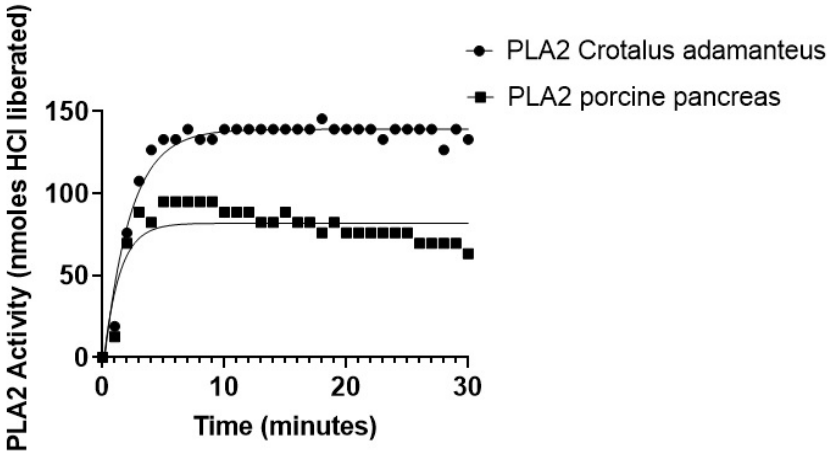
Figure 5. Assay of PLA2 from Crotalus adamanteus and PLA2 from porcine pancreas activity with 0.1 mM POPC liposomes, 1 mM CaCl 2 , 1 mg/mL BSA and 0.05 mM BTB. Absorbance was recorded at 620 nm and converted to nmols released.